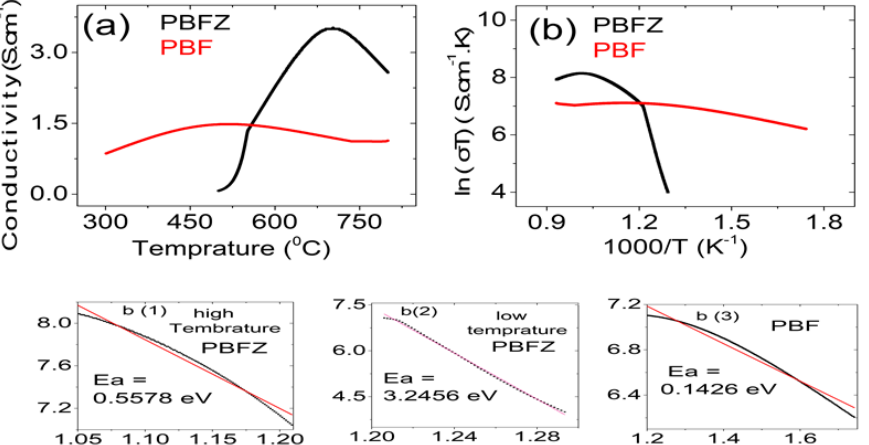
Figure 2. ( a ) Electrical conductivity of the PBFZ and PBF samples from 300 °C to 800 °C; ( b ) ln( σ T) vs. 1000/T (Arrhenius plot): ( b(1) , b(2) ) fitting curves for PBFZ at different temperature range; ( b(3) ) fitting curve for PBF sample.